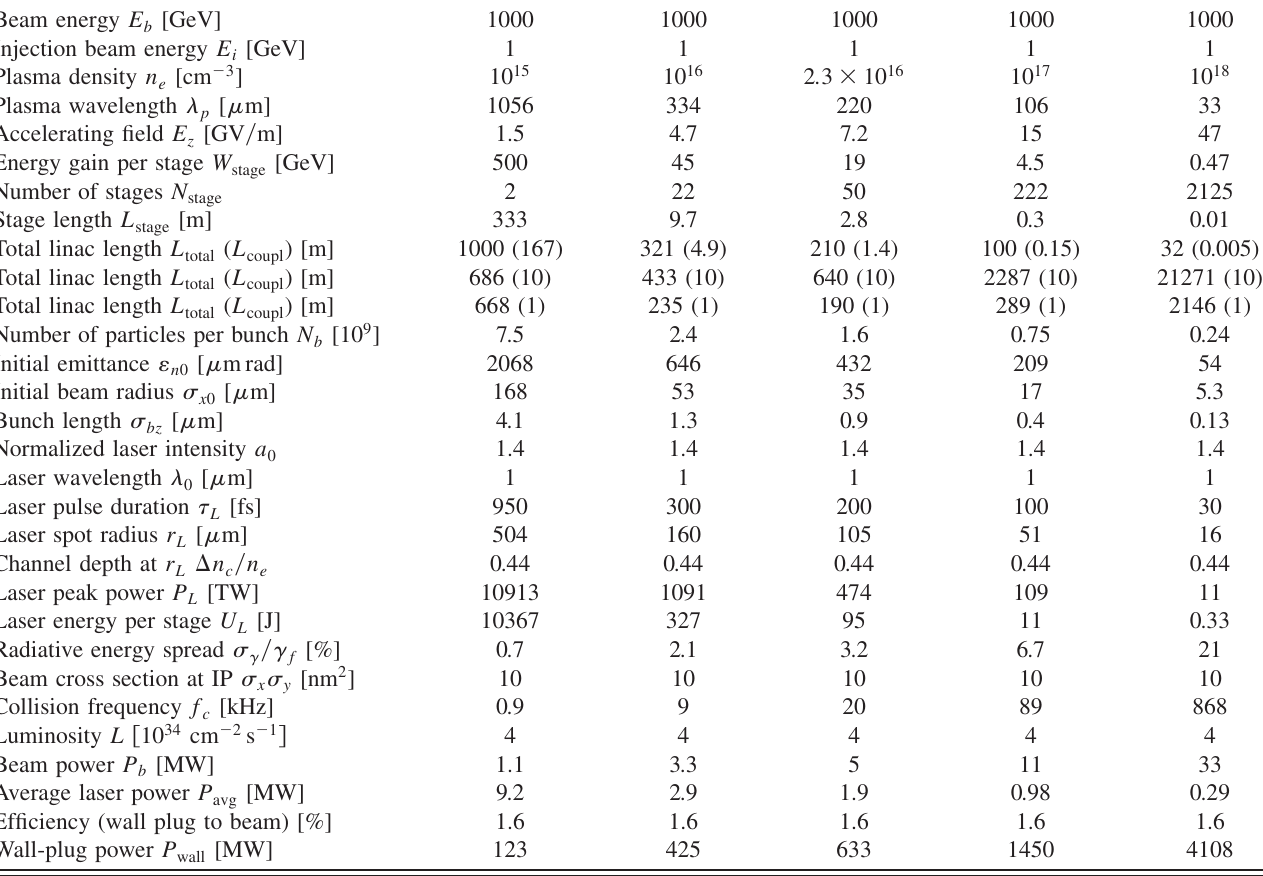
TABLE I. Parameters for a 2 TeV laser-plasma linear